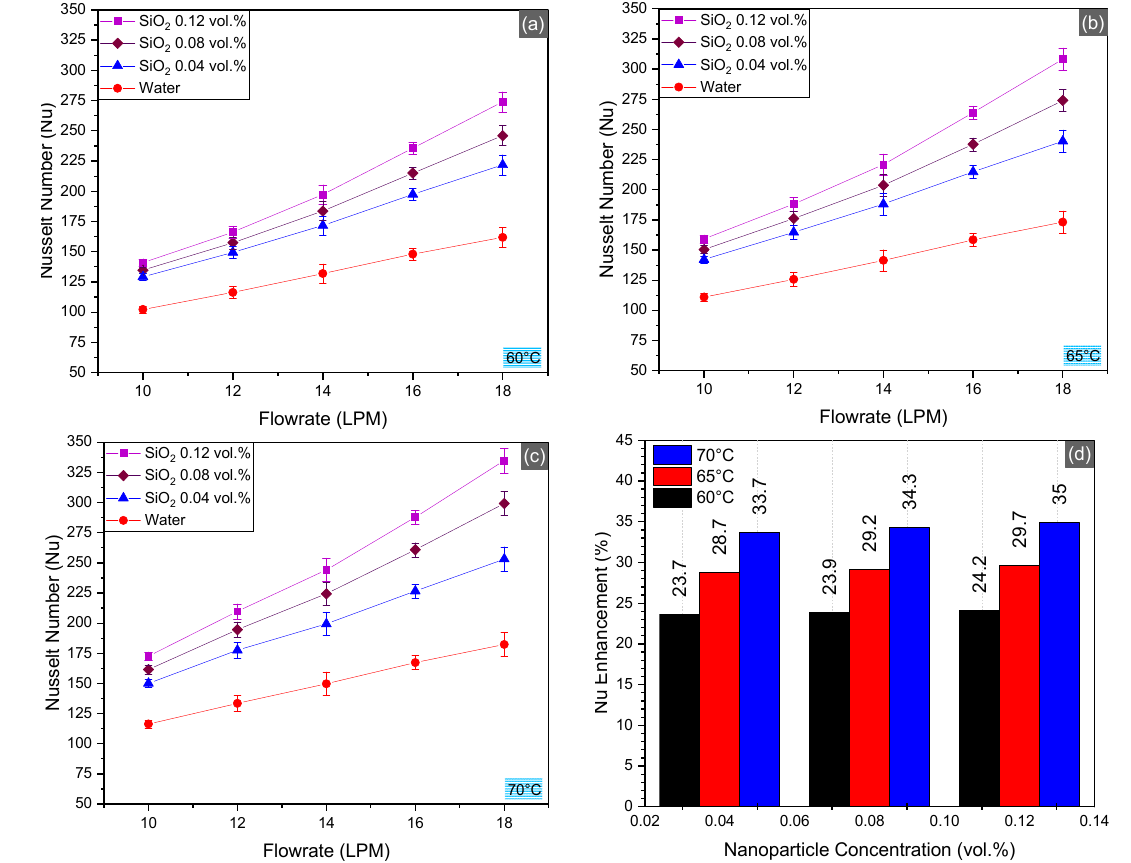
Figure 8. Nusselt number (Nu) in the radiator at inlet temperatures 60–70 ◦ C ( a – c ) and average enhancement Nu for SiO 2 /water nanofluid as compared to the basefluid ( d ).